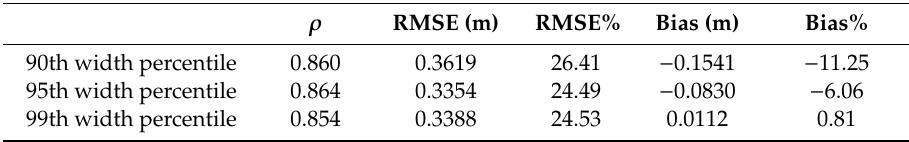
Table 3. Results of the comparison of the LiDAR-estimated crown profile against field-measured model values. ρ RMSE (m) RMSE% Bias (m)